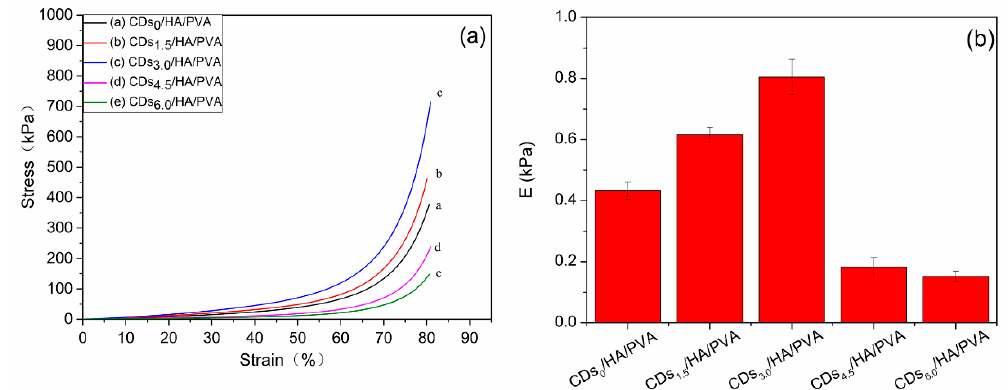
Figure 3. ( a ) The compression stress-strain curves and ( b ) Young’s modulus of the CDs / HA 0.6 / PVA SN hydrogels with different mass ratios of CDs to PVA at ( a ) 0.0%, ( b ) 1.5%, ( c ) 3.0%, ( d ) 4.5%, and ( e ) 6.0%, respectively.